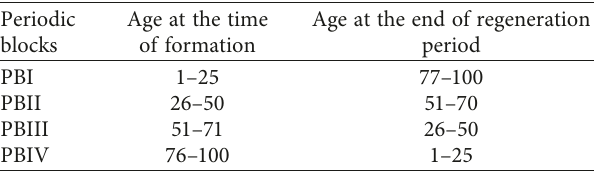
Figure 1: Study area: Muree Hill, Punjab, Table 1: Theoretical sketch of the system.